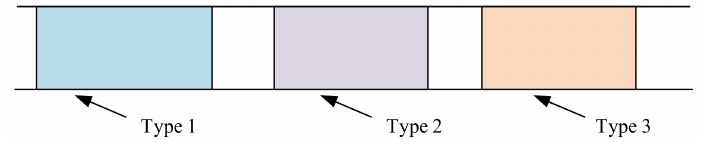
Figure 4. Schematic of field test sections for the three VTAOs.